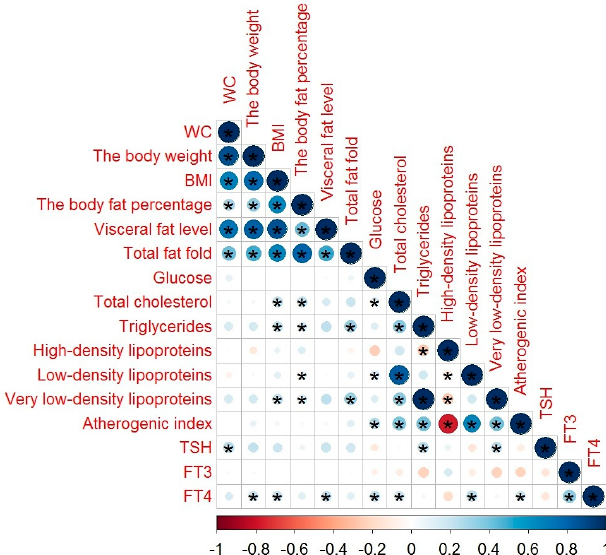
Figure 2. The correlation between body fat parameters, glucose and lipid profiles, TSH, and THs levels in schizophrenia patients without MetS: in this figure, red and blue circles mean negative and positive correlations, respectively; the size and color intensity of circles are proportional to the correlation coefficient; * p -value < 0.05; in the bottom, the legend of color intensity shows the rate of correlations and the corresponding relations.